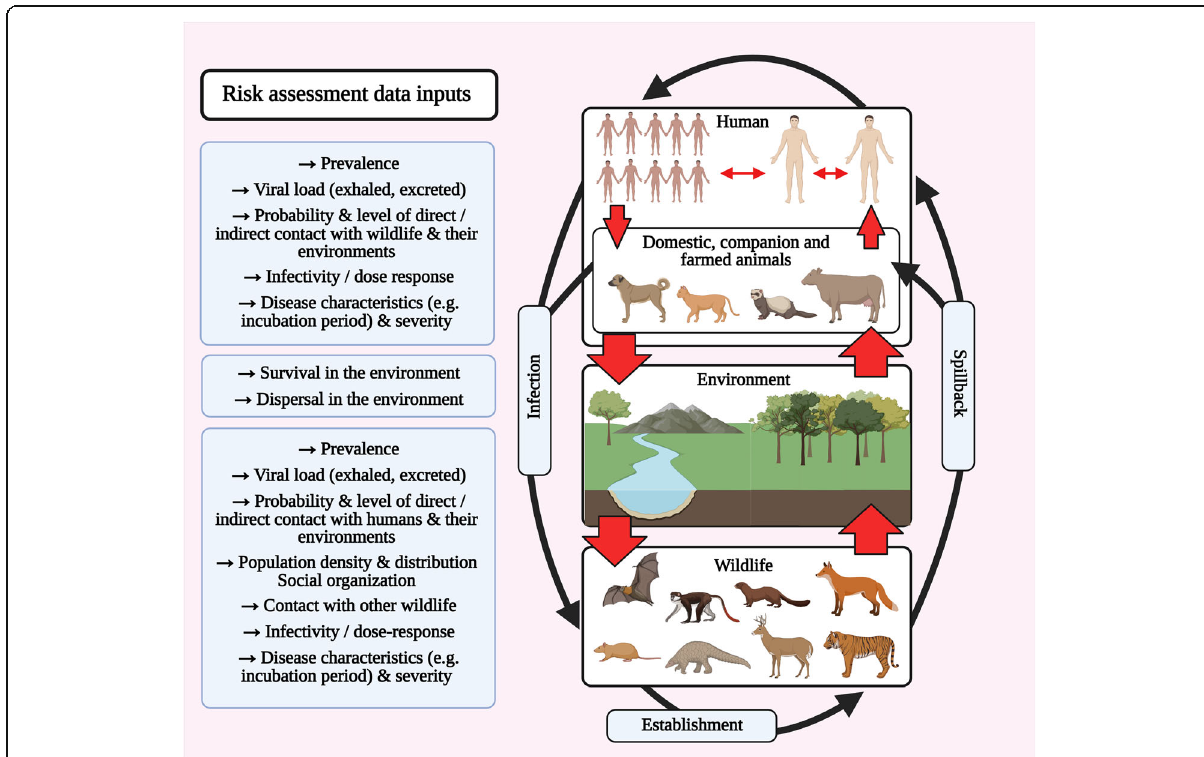
Fig. 1 Potential pathways of SARS-CoV-2 transmission in a multi-host system and sources of data for the assessment of associated